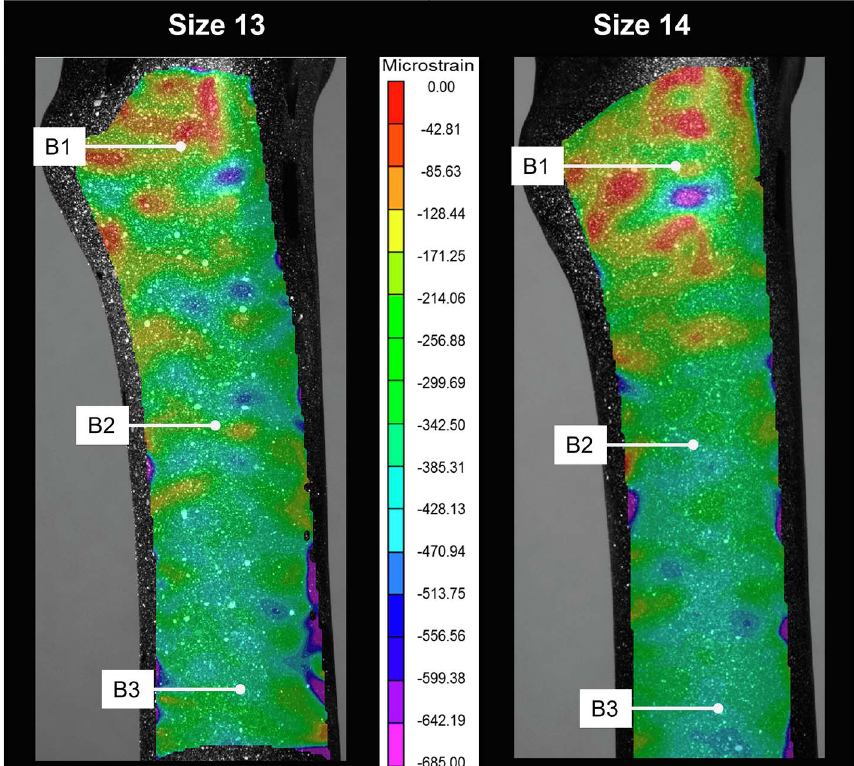
Figure 4. Comparison between the pattern of maximum principal strain across the medial side of the bone, between the size 13 and size 14 group at 500 N axial